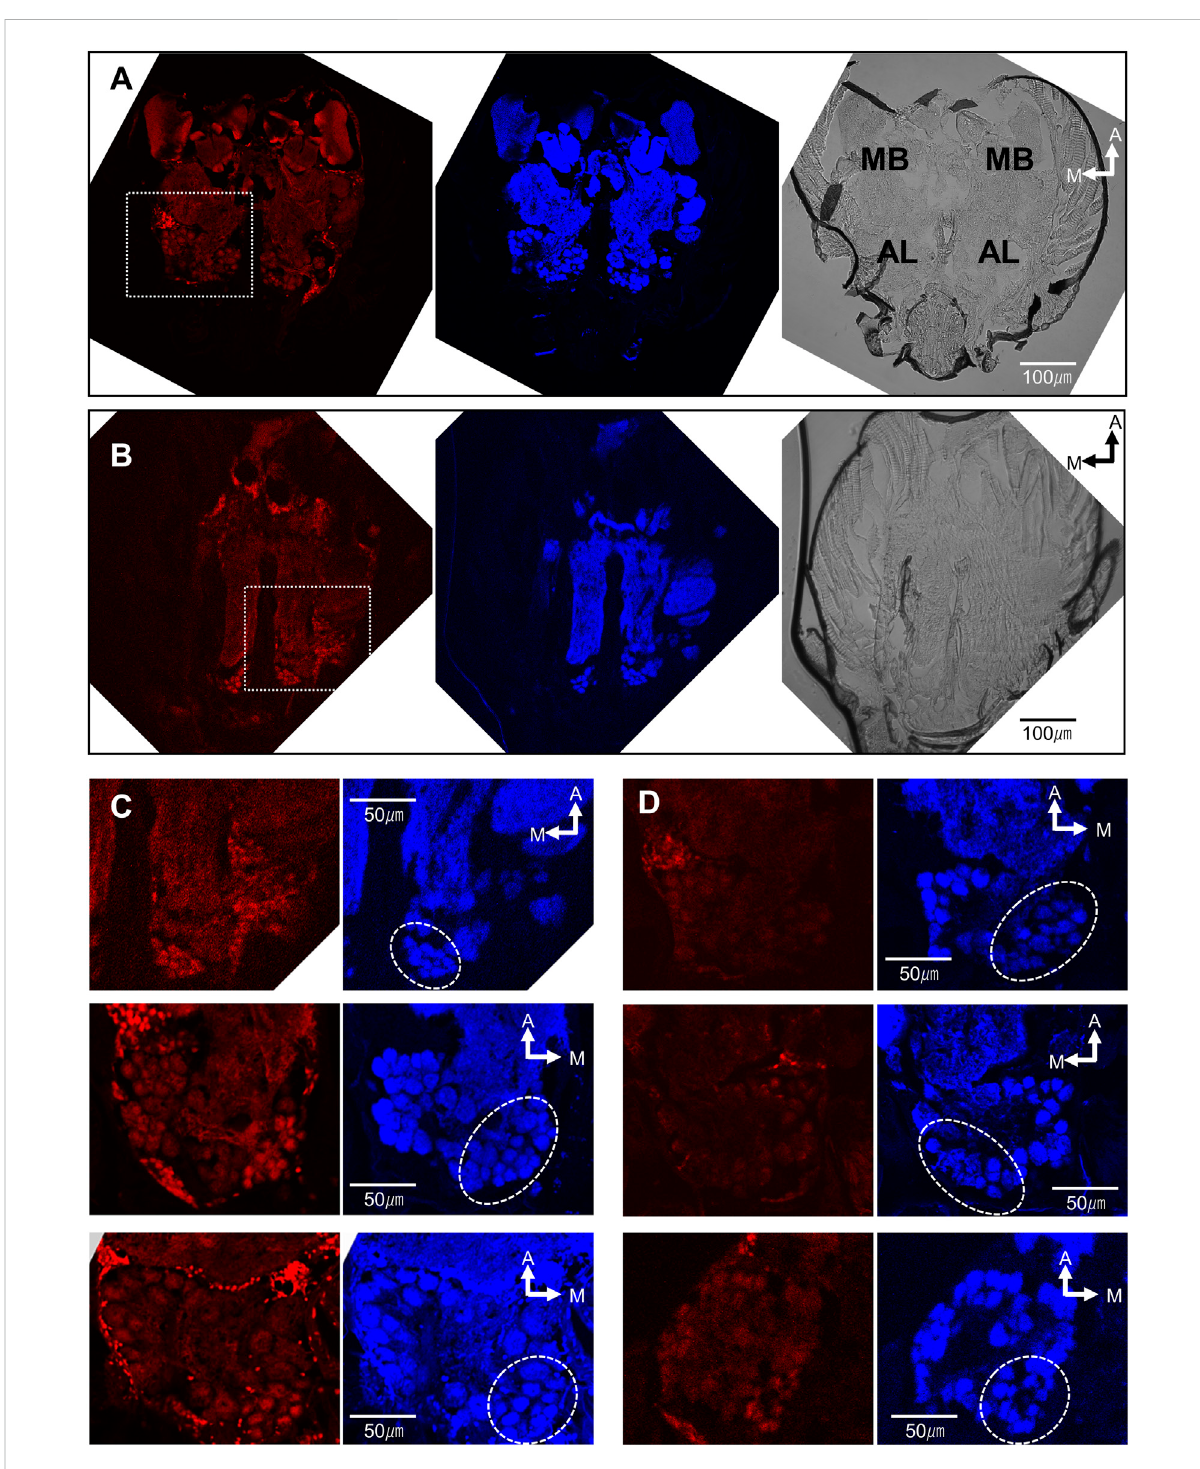
The brain of L. humile activated by the contact stimulation of antennae with ( Z )-9-tricosene. (A − D) (Left) Histochemical fl uorescent staining withanti-pERK-antibody;( A,B) (Middle); (C,D) (Right) Histochemical fl uorescentstainingwithanti-synapsin-antibody,correspondingto (A − D) (Left), respectively; (A,B) (Right)Nomarskidifferentialinterferencemicroscopicimages,correspondingto (A,B) (Left),respectively.MB,Mushroombody.AL, antennal lobe. (A) The representative brain of the ant, chemically non-stimulated. (B) The representative brain of the ant, chemically stimulated with( Z )-9-tricocene. (C) (Top)Magni fi edimageofthedotted-linesquareareain (B) (Left). (D) (Top)Magni fi edimageinthesamebrainas (A) (Left). (C) (Middle and Bottom) Magni fi ed images in two other brains at the same level but in the opposite side AL of (C) (Top). Dotted circles indicate the glomerular clusters of T6-like region on the anti-synapsin-antibody staining